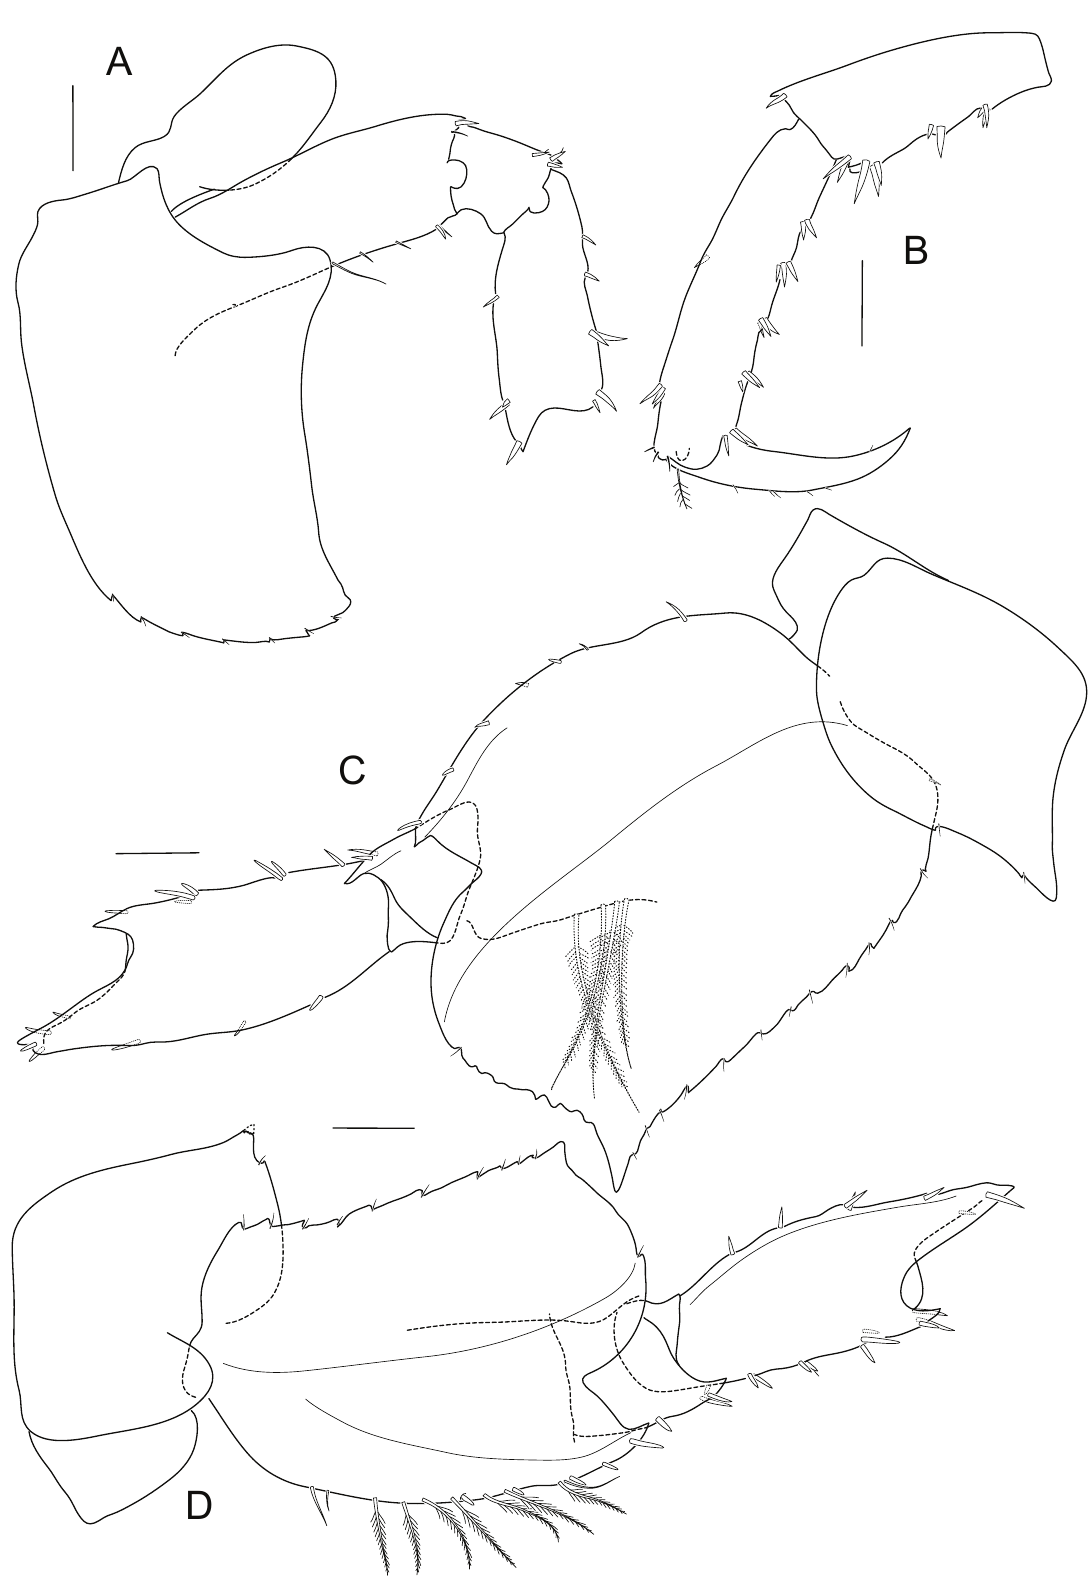
Fig. 10. Labriphimedia martinae nov. sp., holotype ♂, 6.5 mm, NIWA 84743. A . Pereopod 4. B . Presumed carpus to dactylus of pereopod 4. C . Pereopod 7. D . Pereopod 6. Scale bars: a-D = 100